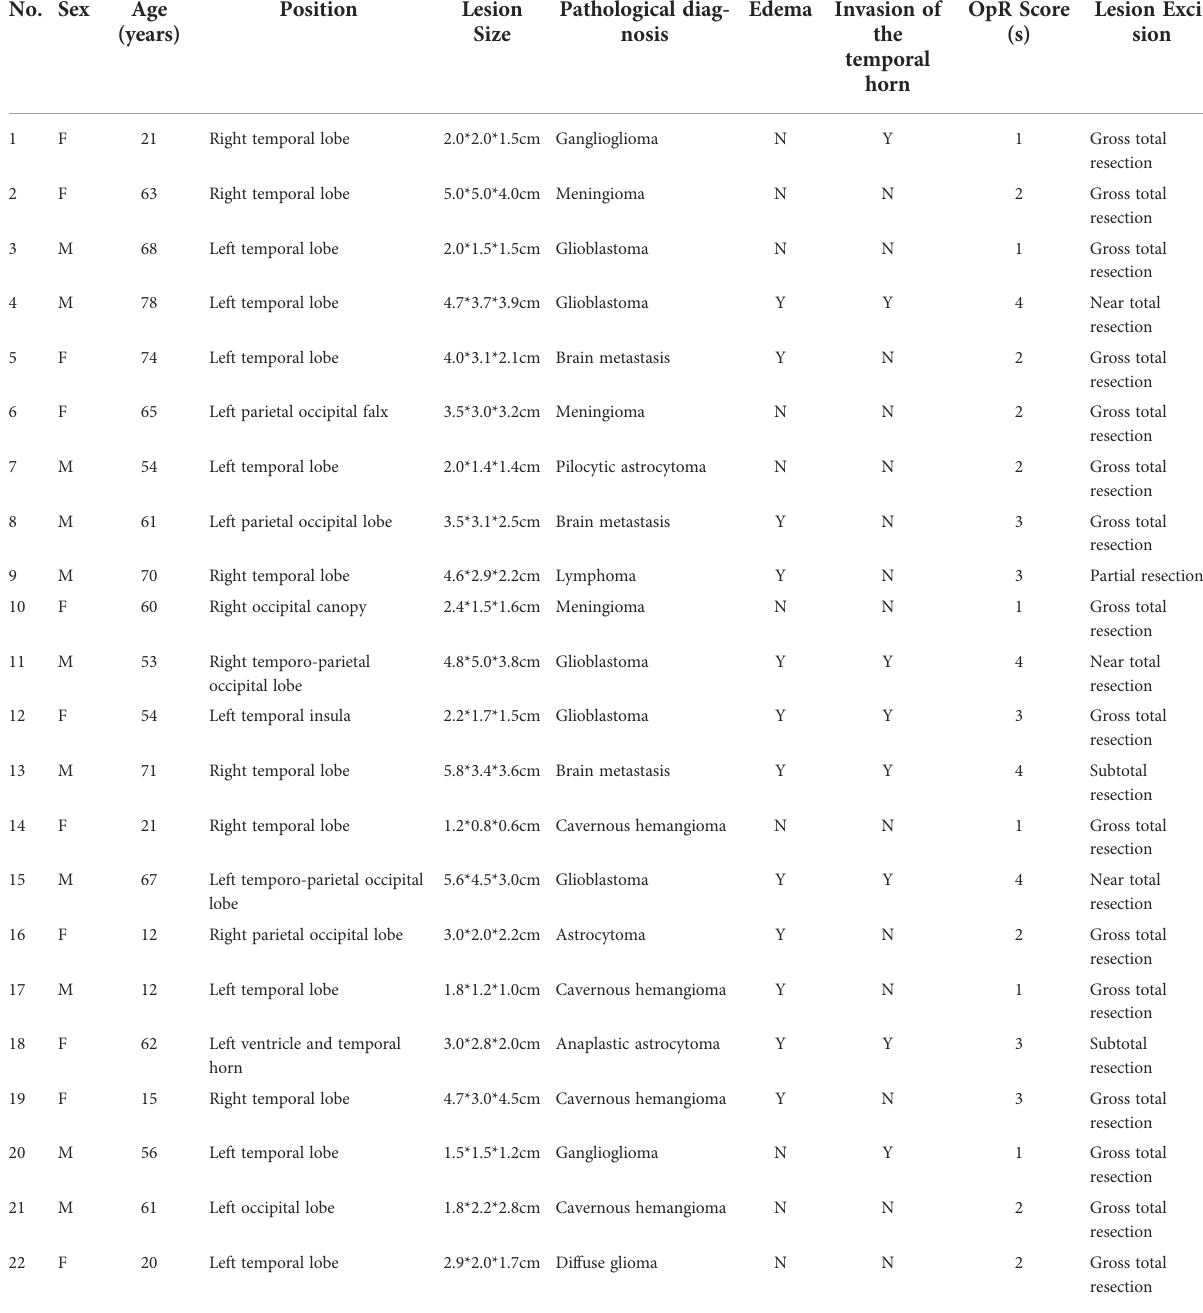
TABLE 1 Patient demographics and clinical